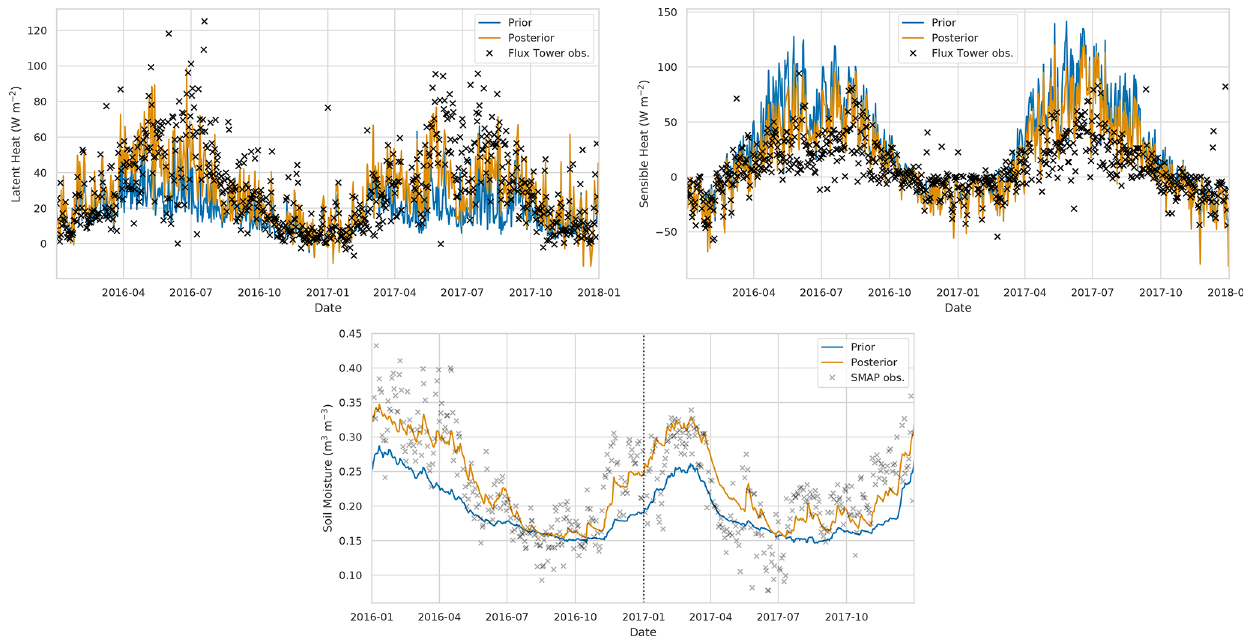
Figure 15. Time series of heat flux variables and soil moisture at Cardington flux tower site. Black crosses: flux tower observations, grey crosses: SMAP observations for closest 9km pixel, blue line: prior JULES estimate for closest 1km grid cell, orange line: posterior JULES estimate for closest 1km grid cell.